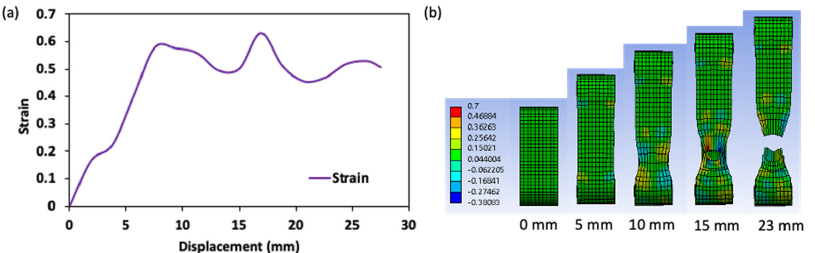
Figure 10. Strain distribution in surimi gel during the ring tensile test; ( a ) quantitative strain value and ( b ) contour description of the strain concentration region.